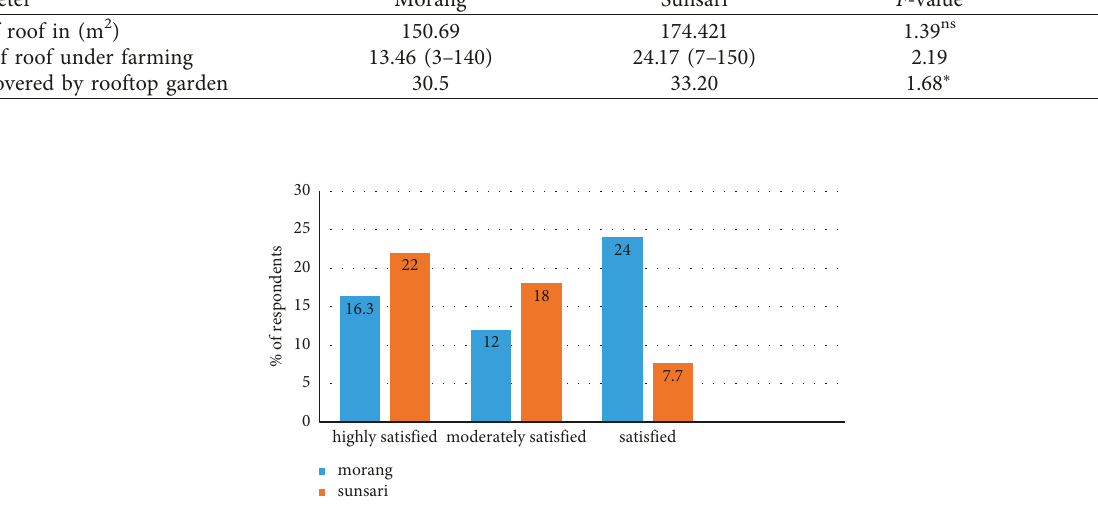
Figure 5: Satisfaction of rooftop adopters in its